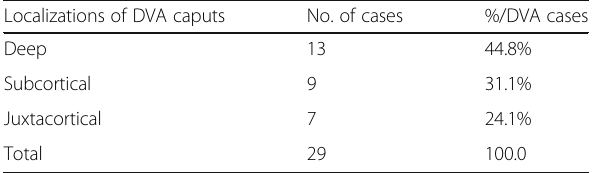
Table 3 Localizations and frequencies of DVA